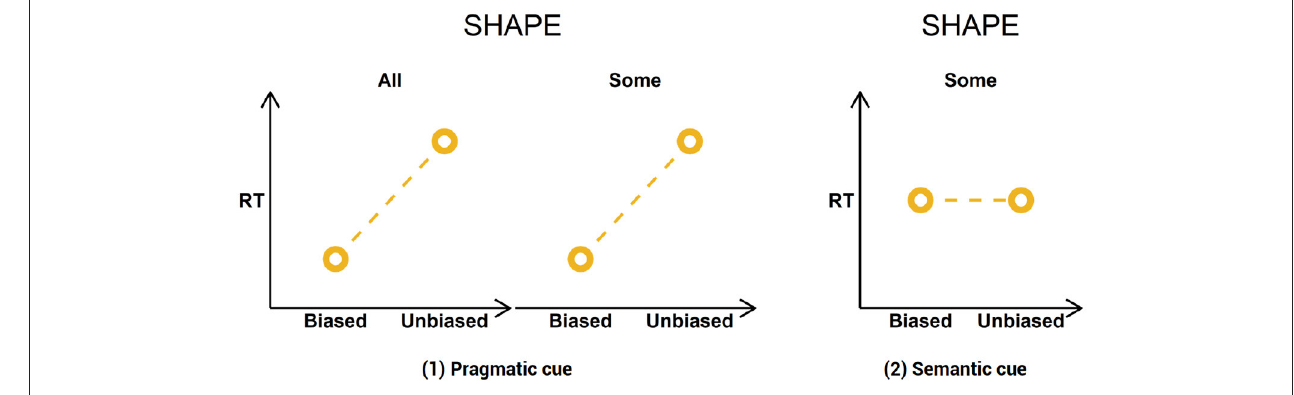
FIGURE 5 | Study predictions.